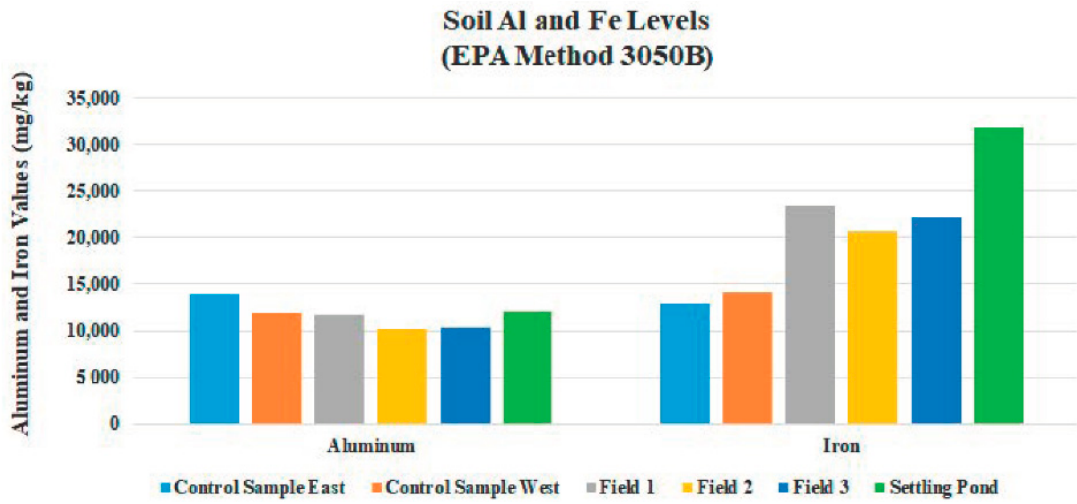
Figure 9. Soil phosphorous, potassium, and sulfur of Fields 1, 2, and 3 and Control Samples East and West.